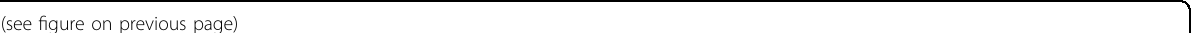
Fig. 1 palmitate acid (PA) stimulates the expression of peroxidasin (PXDN) and promotes cell death in a time and dose manner. A H9C2 cells were treated with different concentrations of PA (0, 200, and 400 μ M) for 24 h. PXDN protein level was measured by western blot and quantitative analysis was shown on the right side ( n = 3). B H9C2 cells were treated with 400 μ M PA for different duration (0, 12, and 24 h). PXDN protein level was measured and quantitative analysis was shown on the right side ( n = 3). C H9C2 cells were treated with different concentrations of PA for 24 h; cell death rate was measured by LIVE/DEAD viability kit. Live cells were stained by vital dyes calcein acetoxymethyl ester (Calcein-AM) and exhibited green fl uorescence, while dead cells were stained by ethidium homodimer-1 (EthD-1) and exhibited red fl uorescence. The percentage of cell death was shown on the right side (scale bar = 50 μ M, n = 4). D Cells were treated with 400 μ M PA for different duration; the cell death rate was measured by LIVE/DEAD viability kit. The percentage of cell death was shown on the right side (scale bar = 50 μ M, n = 4). E Cells were treated with different concentrations of PA for different duration, and glucose consumption was determined ( n = 3). Data were presented as mean ± SEM. One-way ANOVA test was used. * P < 0.05, ** P < 0.01, *** P <